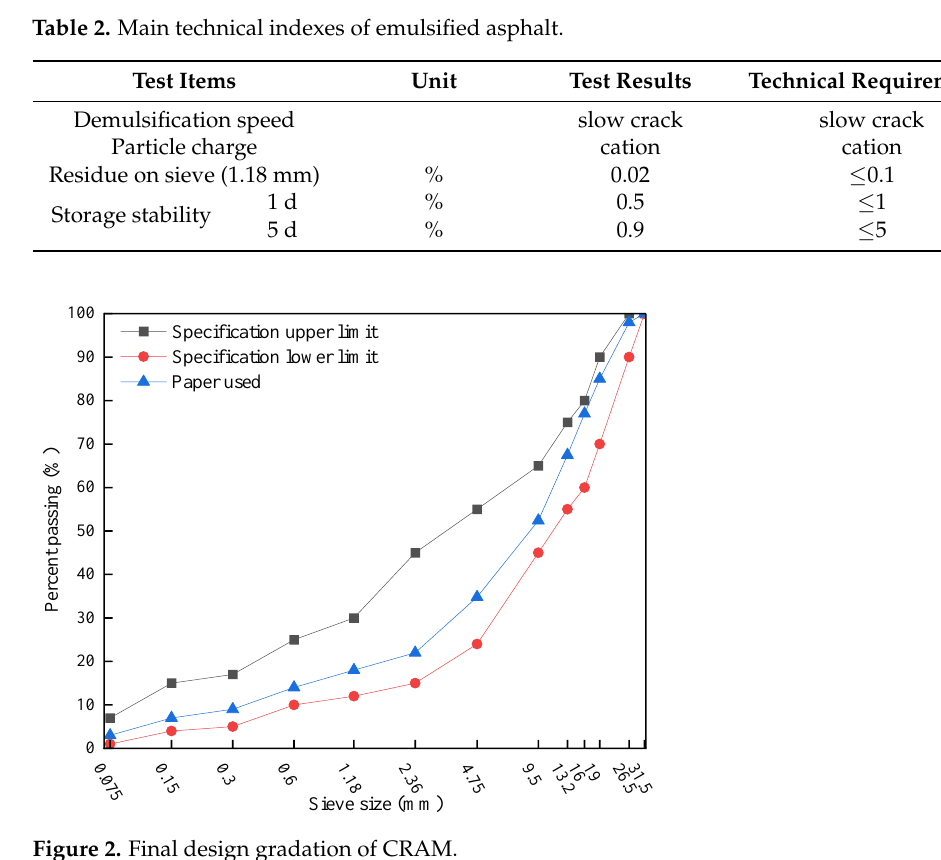
Figure 2. Final design gradation of CRAM.